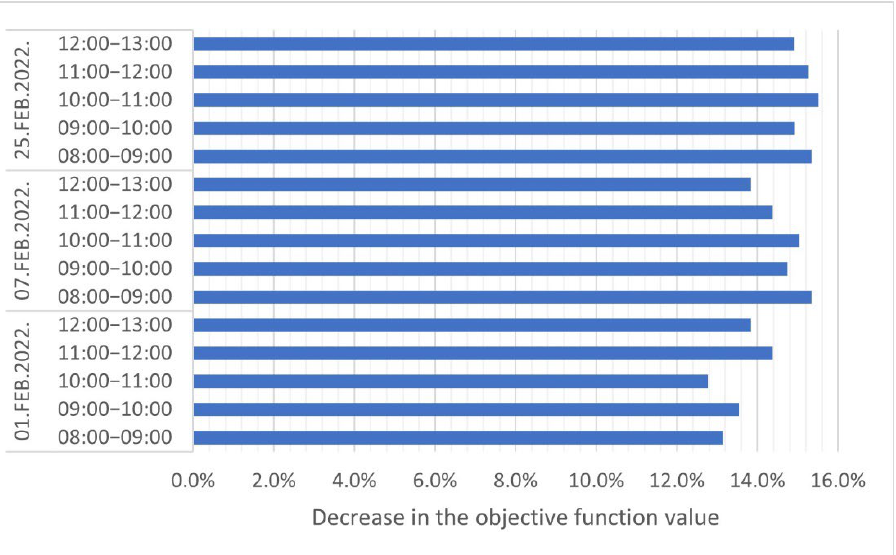
Figure 8. Decrease in the objective function values, achieved by optimizing inbound dock door al- location.